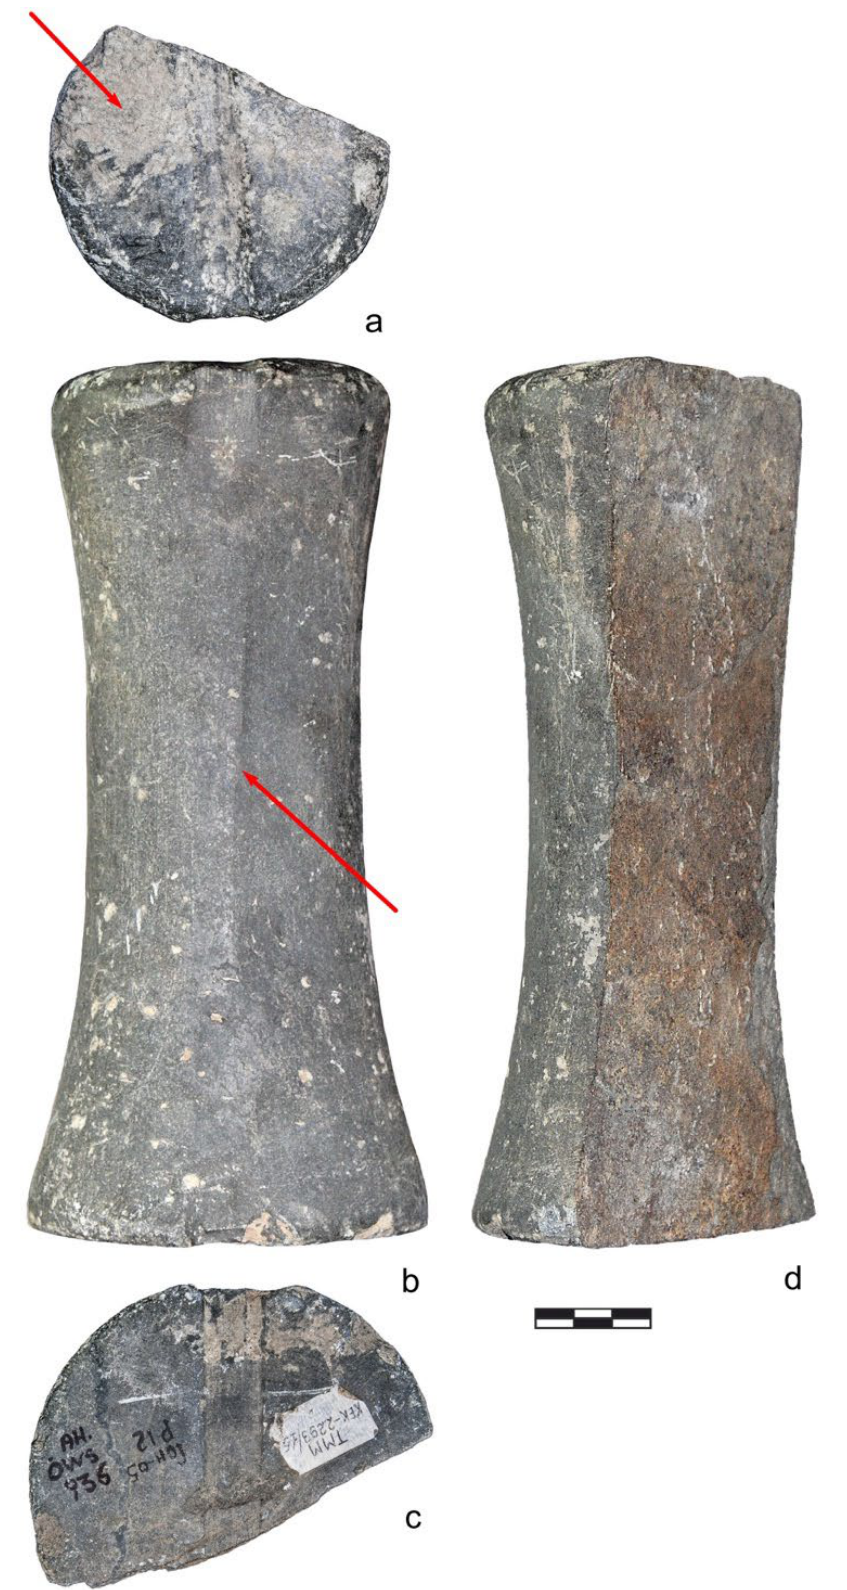
Figure 22. Deliberately broken miniature column from Gonur Depe with narrow stripe connecting the ends of the top and bottom grooves (from the depositories of the National Museum of Turkmenistan, Ashgabat): a. top base with traces of intentional blows; b. side with traces of polishing with a soft material; c. bottom base; d. broken side of the column. Scale bar is 3 cm long, separated into three 1 cm